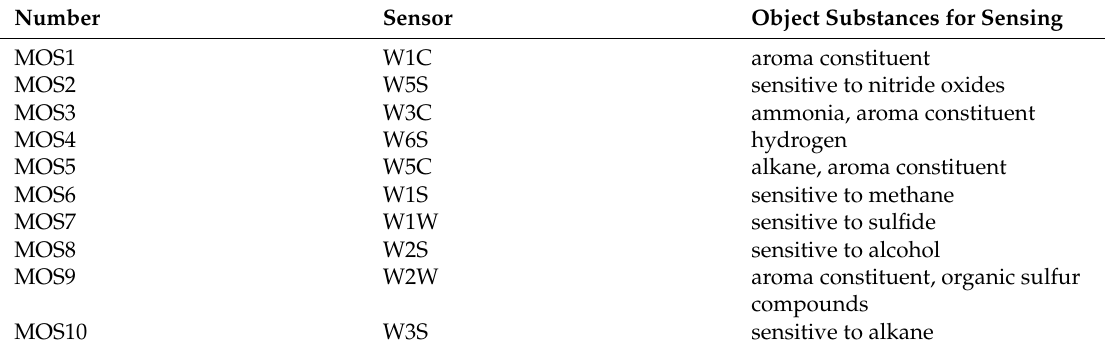
Table 1. The details of sensor array in PEN3 [27]. Figure 1. Experimental setup: (a) experimental equipment and (b) internal structure of PEN3 [27].